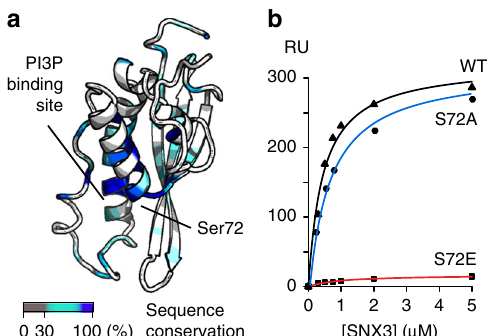
Fig. 5 Mutation of the conserved PIP-stop residue Ser72 modulates membrane association. a The conservation of SNX3 residues is colored on the ribbon structure as indicated in the inset. The proximal Ser72 and PI3P pocket positions are indicated. b The binding af fi nities of wild type SNX3 and S72A and S72E mutants for PI3P-containing bilayers were measured by SPR, and show that the S72A mutation preserved activity whereas the